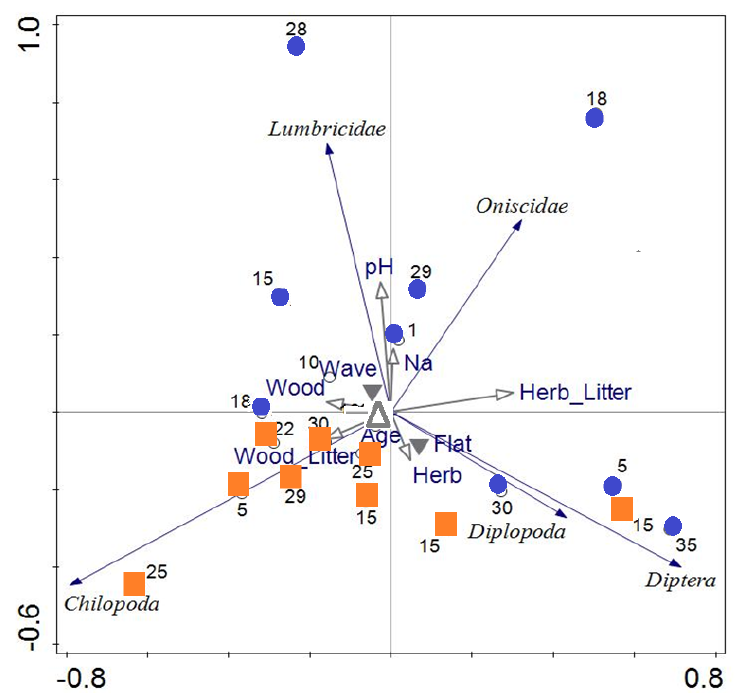
Figure 6. PCA of fauna composition in postmining sites of various ages that were either levelled (orange squares) or not (blue circles). Control is a forest unaffected by mining (grey triangle).